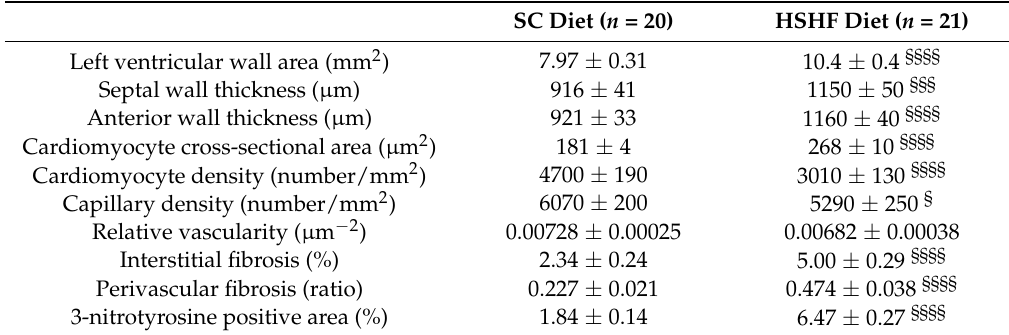
Table 2. Morphometric and histological parameters of the left ventricular myocardium in C57BL/6N mice fed the SC diet or the HSHF